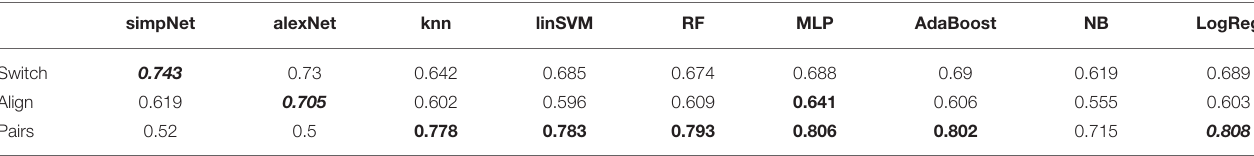
TABLE 3 | Person-independent: Average classification accuracies over all folds of the group-five-fold cross-validation for the person-independent classifier; bold and italic , highest accuracy for this task; bold , p -value of the one-sided Wilcoxon Signed Rank Test above 0.05, thus no statistical difference between this and the best performing classifier.